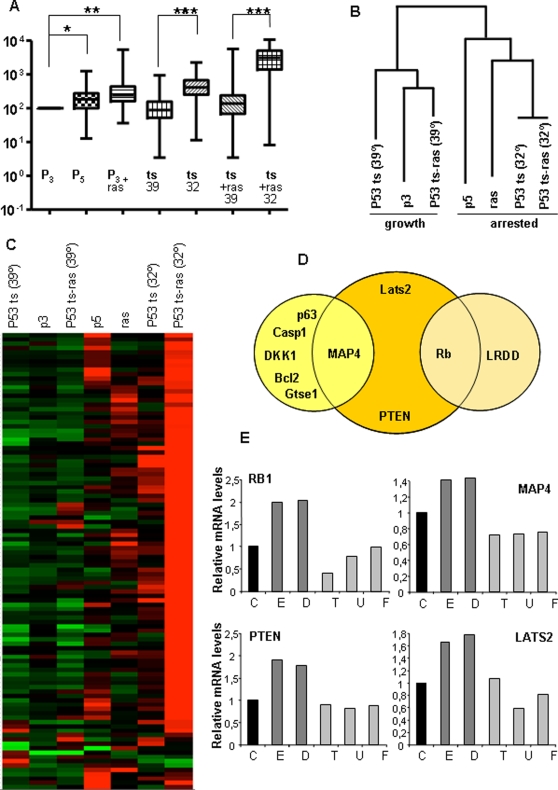
Analysis of the p53-dependent transcriptional signature.A) Comparison of the levels of 122 transcriptional targets of p53 at different conditions of p53 activity. See text. Data normalized against β-actin were compared to the proliferative condition P3 to evaluate its statistical significance. Statistical analysis was performed by paired t-test. (*) = p<0.05; (**) = p<0.005; (***) = p<0.001. B) and C) Analysis of the expression values of 122 transcriptional targets of p53 under different cellular conditions, which led either to proliferation or to growth arrest. Clustering analysis. Hierarchical clustering was performed using the function hcluster (package amap) of the free statistical software R. See M & M. The expression level of each gene, relative to its median expression level across all conditions, was represented by a color, with red representing expression greater than the median, green representing expression less than the median, and the color intensity representing the magnitude of the deviation from the median. D) Feature selection. Since the number of genes is much greater than the number of conditions, we used penalized regression methods. See text and M & M for more details. E) Validation of the feature selection by quantitative PCR. See text and M&M. We determined Lats2, DKK1, pRb and PTEN mRNA levels after 24 hts treatment of HCT116 cells with the indicated treatment, by quantitative PCR. Cyclophilin (ref. 4326316E), an endogenous control, was used to normalize variations in cDNA quantities from different samples. Each reaction was performed in triplicate with cDNA from normal and tumor tissue from each patient studied. C shows untreated samples. E: Etoposide, D: Doxorubicin, T:Taxol, U: UCN-01, F:Flavopiridol. Data shows average of three determinations.